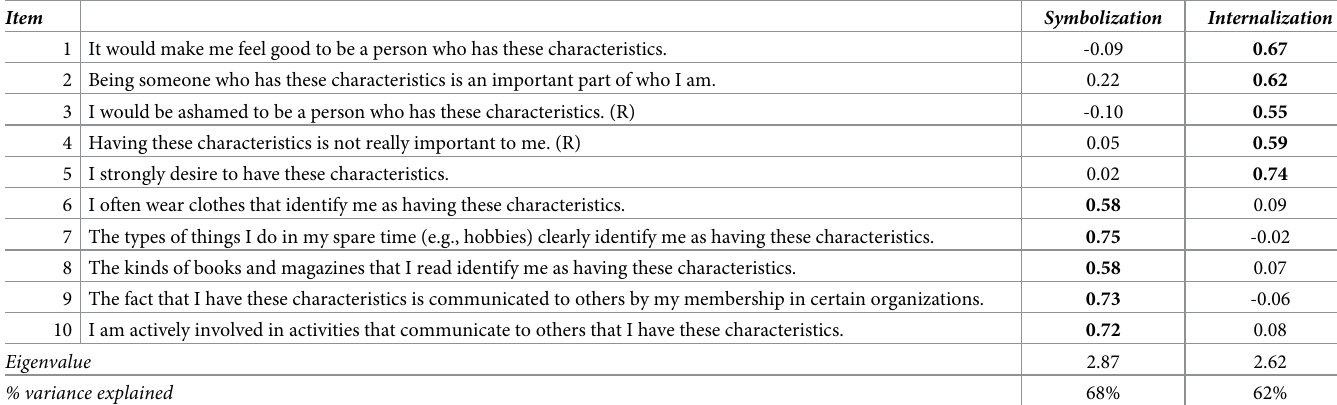
Table 2. Exploratory Factor Analysis (EFA) factor loadings of SMIS